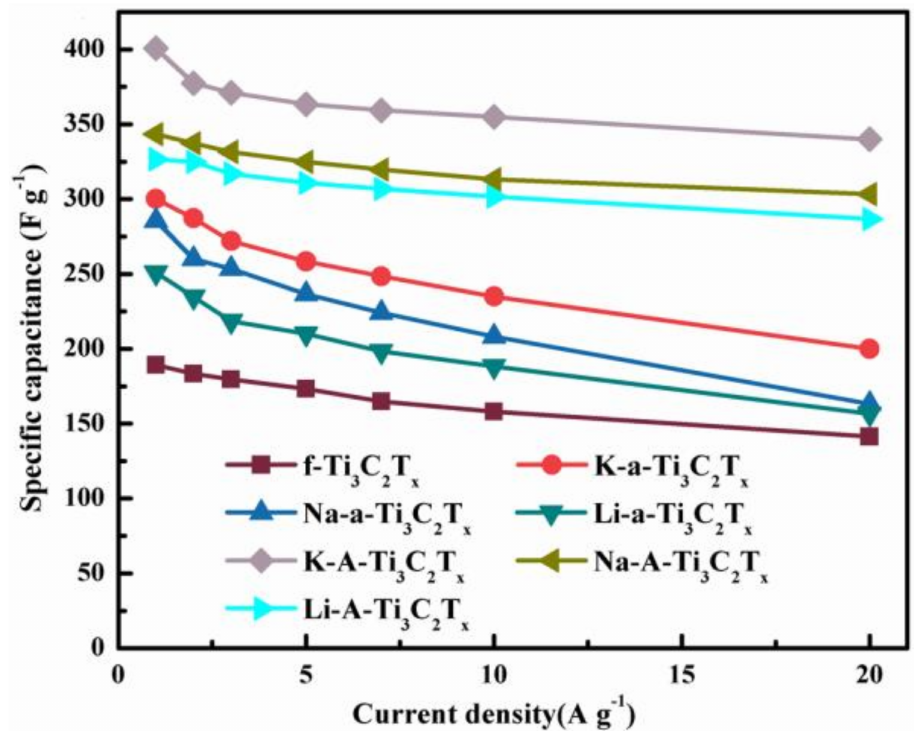
Figure 9. Specific capacitance of the Ti 3 C 2 T x electrode at the scan rates of 1–20 A g − 1